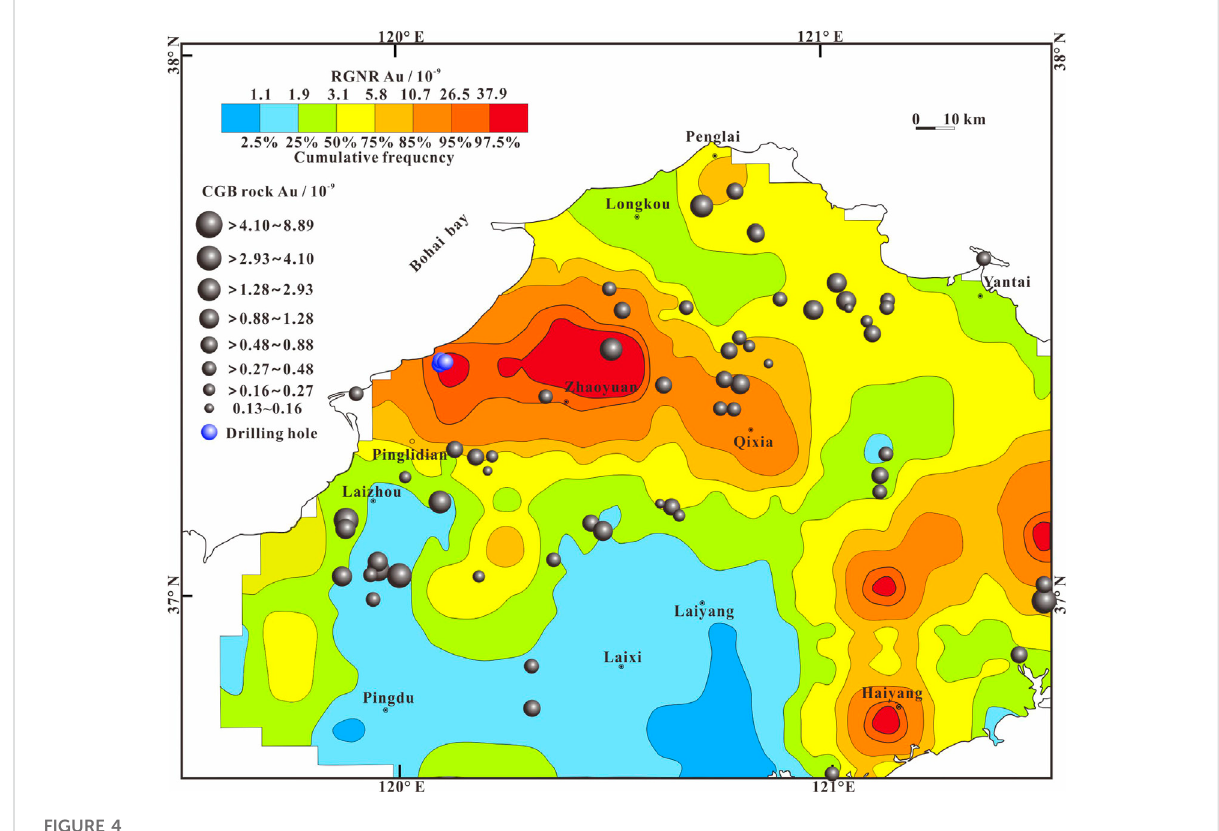
FIGURE 4 Geochemical map of gold of RGNR and CGB rock in Jiaodong gold